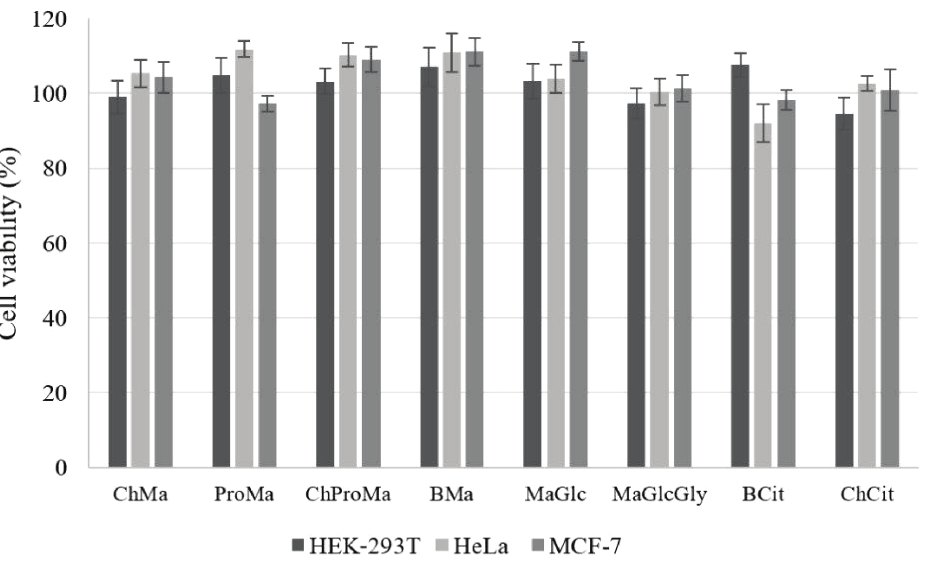
Fig. 8 – Effect of NADES containing carboxylic acids on viability of HEK-293T, HeLa, and MCF-7 cells determined by the CellTiter 96 ® AQueous One Solution assay. The results for the highest-tested concentration (2000 mg L –1 ) of NADES are shown. Cell viability (%) was expressed as percentage of treated versus control cells, and the data are the means ±S.D of four replicates for each exposure